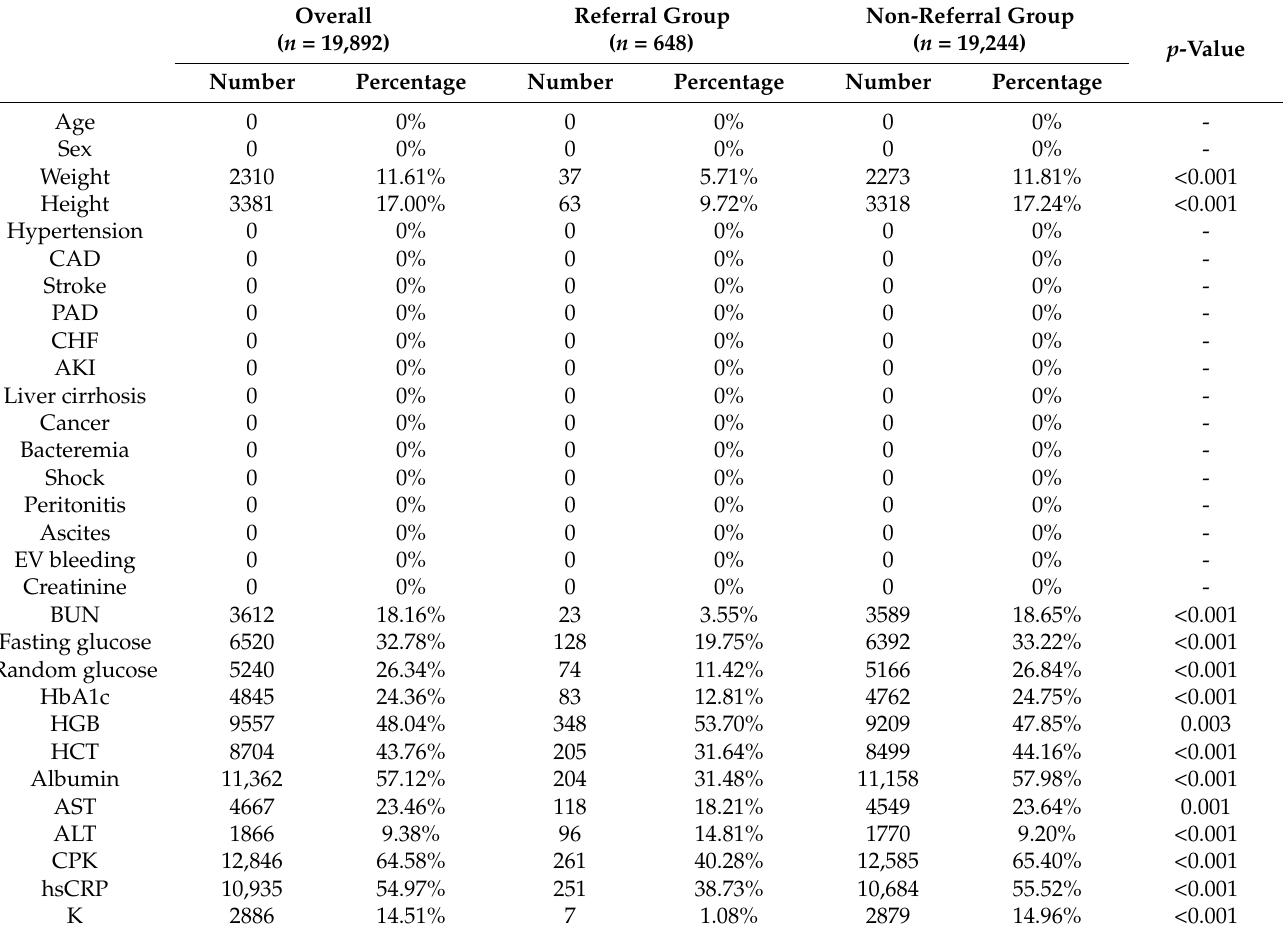
Table A2. Missing data in experiment